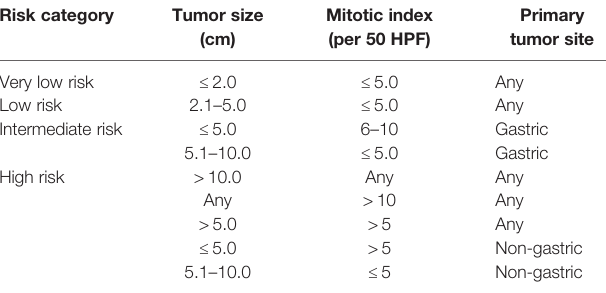
TABLE 1 | NIH 2008 criteria for de fi ning risk strati fi cation of GISTs recurrence after surgery. Risk category Tumor size